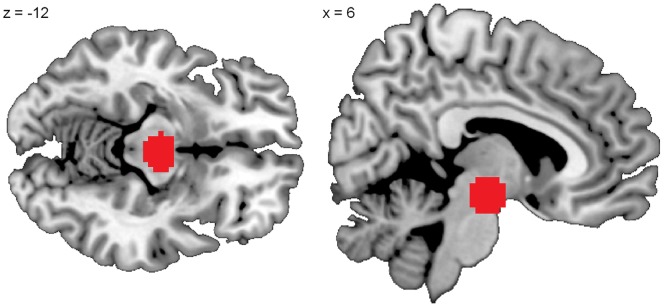
Mask for the ventral tegmental area (VTA): The region of interest was drawn manually on MRI-based anatomy using an anatomical atlas (Duvernoy HM (1995)).